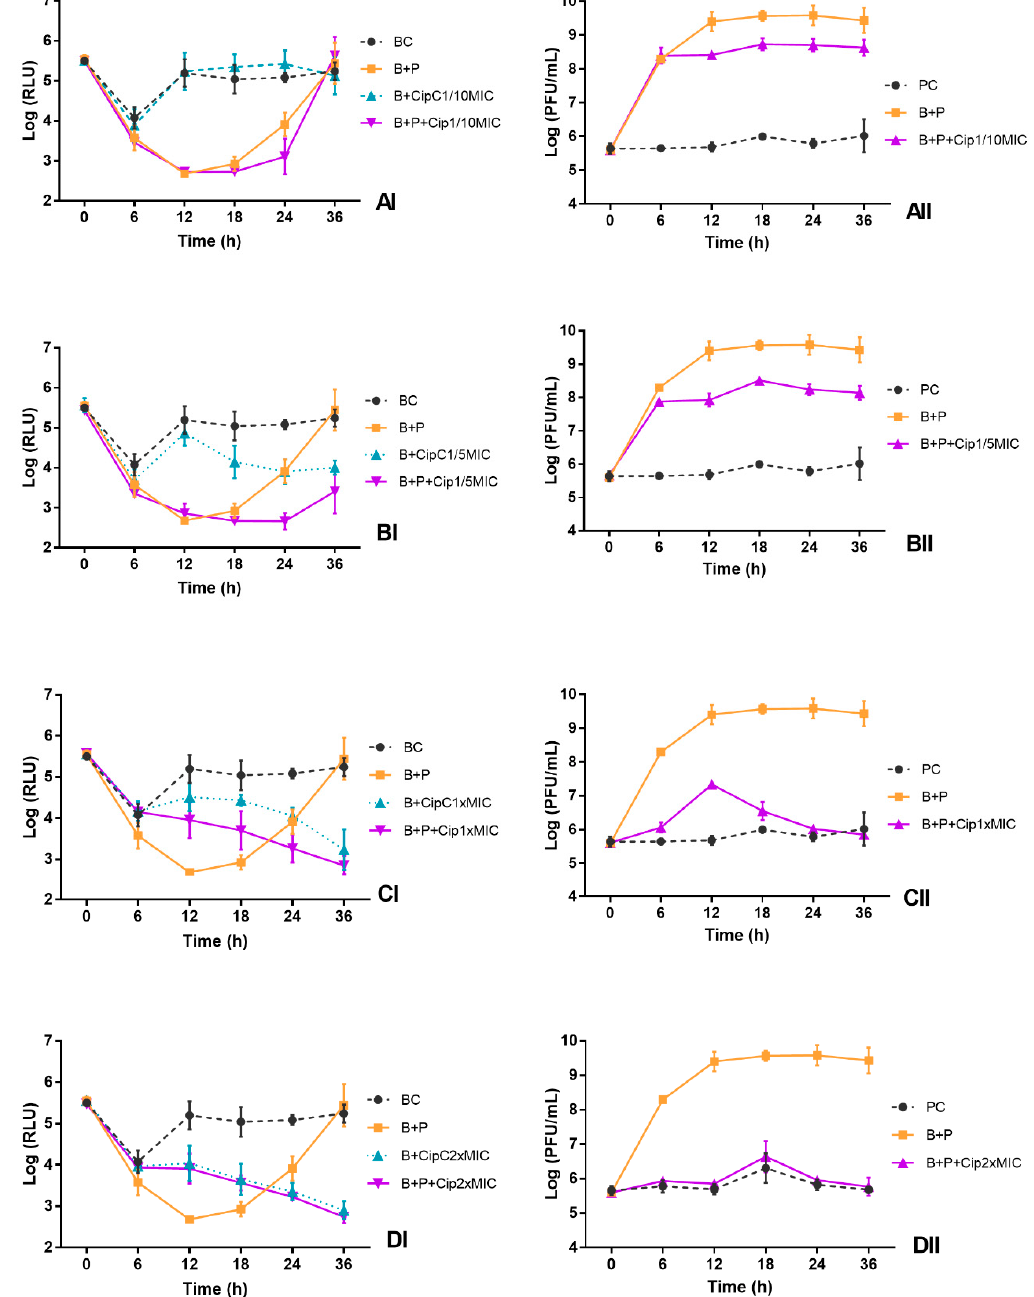
Figure 3. Effect of phage alone (MOI of 1) and of combined phage and ciprofloxacin treatments at different concentrations (( A ) 1/10MIC, ( B ) 1/5 MIC, ( C ) MIC and ( D ) 2 × MIC) on the inactivation of bioluminescent E. coli (I) and the phage concentration (II) in TSB during 36 h. BC, bacterial control; PC, phage control; B + P, bacteria plus phage; B + CipC, bacteria plus ciprofloxacin; B + P + Cip, bacteria plus phage plus antibiotic. Values represent the mean of three independent